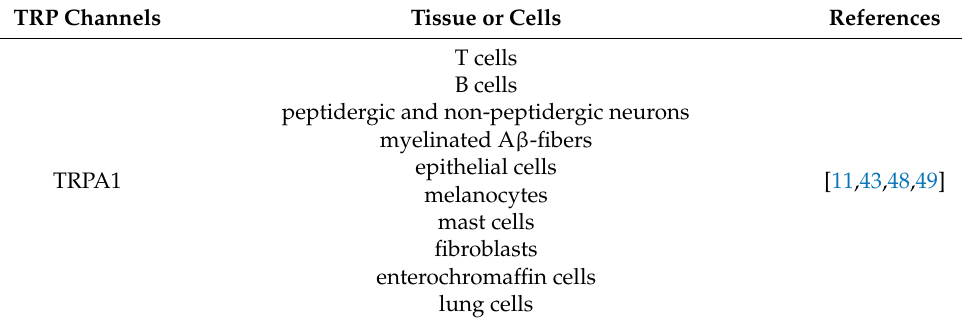
Table 2. Tissue or cells expressing thermosensory TRP